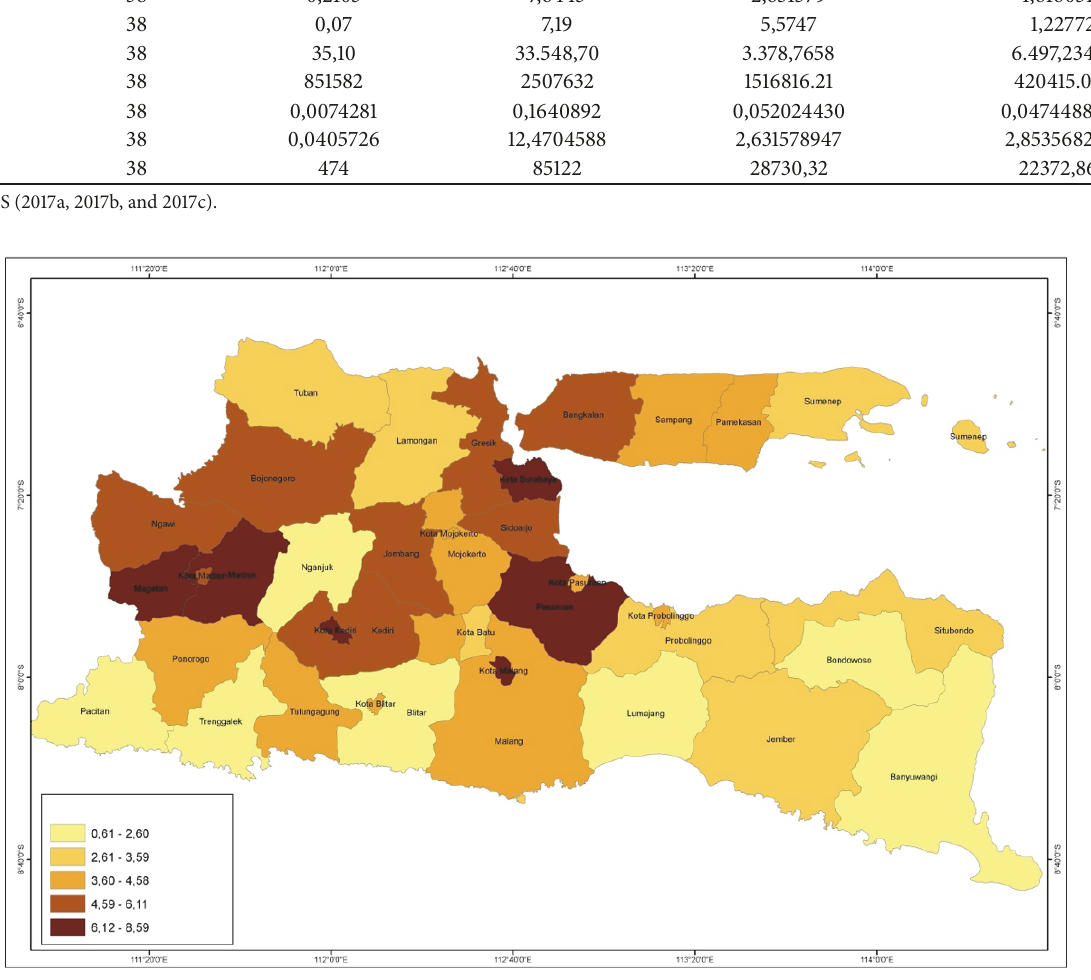
Figure 1: Open Unemployment Mapping in province of Java,